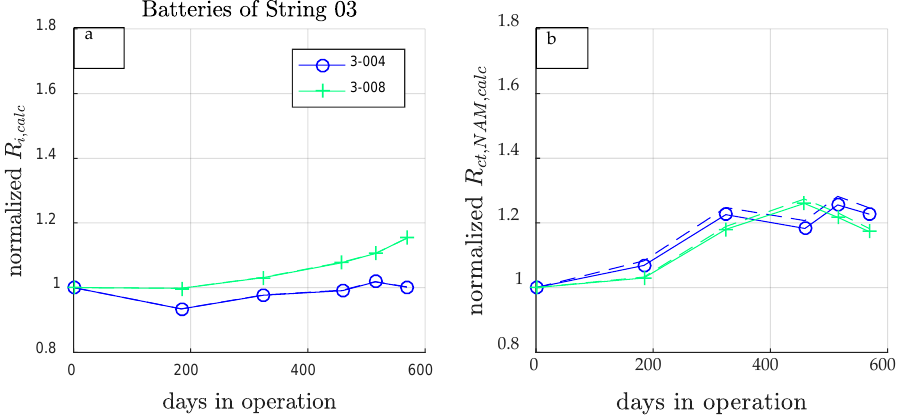
Figure A2. Change of the calculated parameters based on two impedance measurements (100 Hz and 1 Hz) for the batteries of string 3. Solid lines are R (Z) and dashed lines |Z|. ( a ) normalized change of R i,calc based on values measured @100 Hz; ( b ) normalized change of R ct,NAM,calc, which is the delta of impedances @100 Hz and 1 Hz.